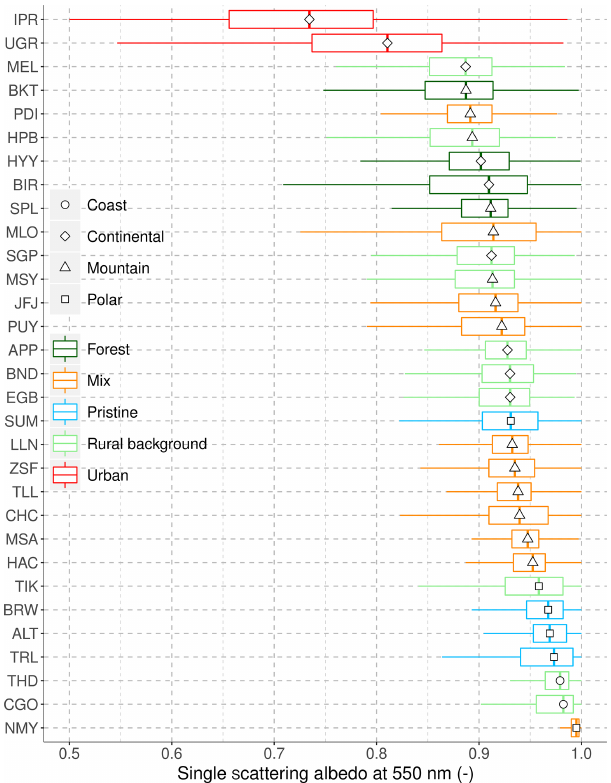
Figure 7. Boxplot of quantiles and annual median for single- scattering albedo at 550nm at the analysed sites. Box colour in- dicates the footprint according to Table